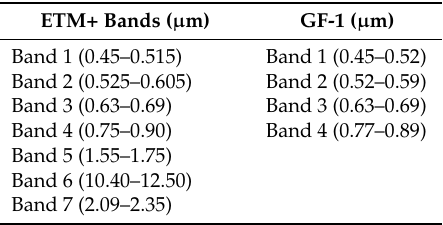
Table 3. Experimental data sources and bands